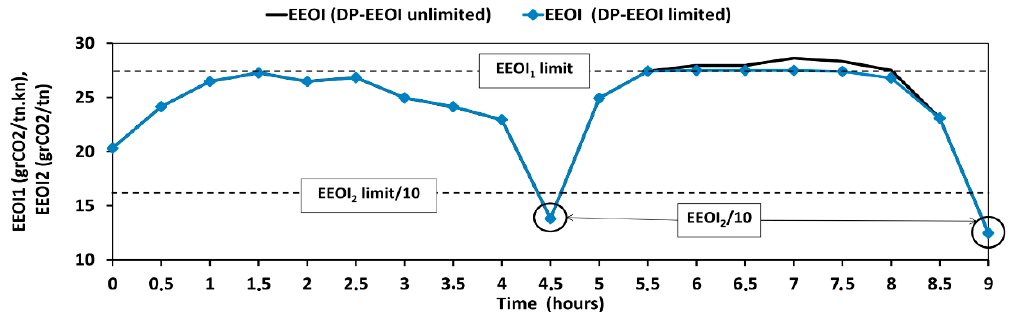
Figure 11. Ship energy efficiency operation index: DP with/without limitation.